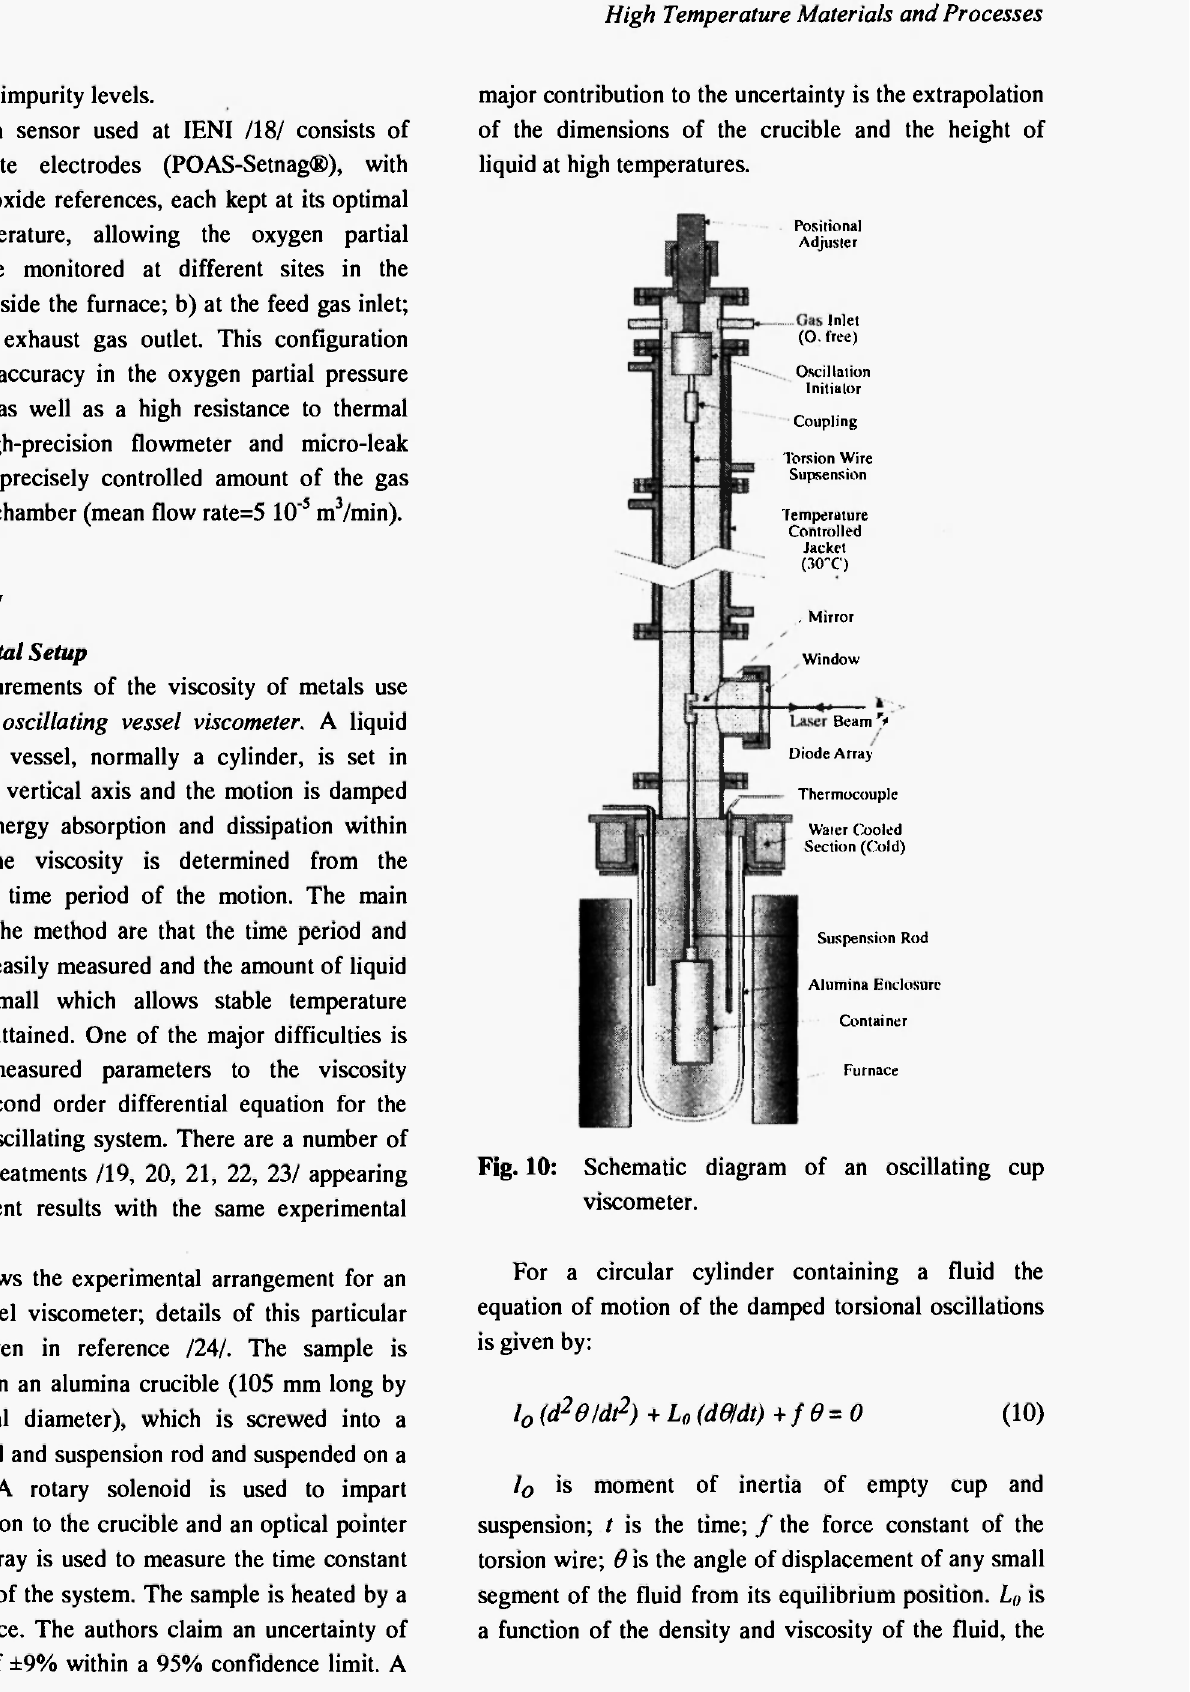
Fig. 10: Schematic diagram of an oscillating cup